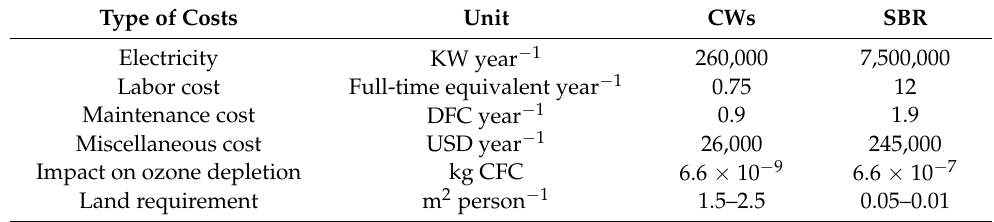
Table 1. Selected cost of constructed wetland and sequencing batch reactor operation